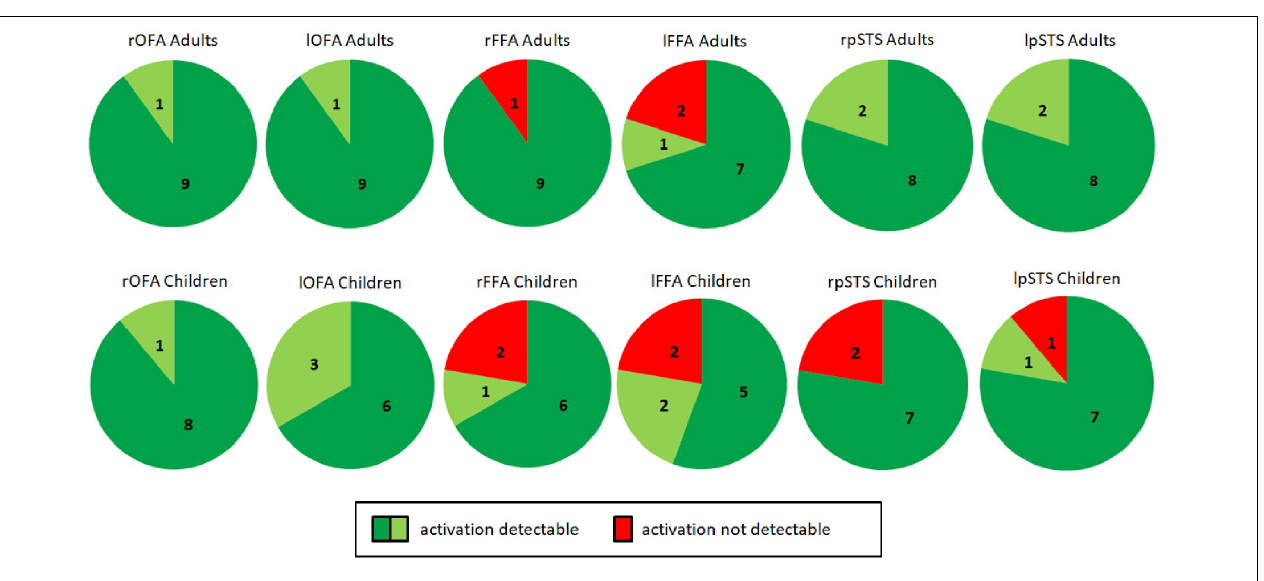
groups for the left and right OFA, FFA and pSTS in Figure 6